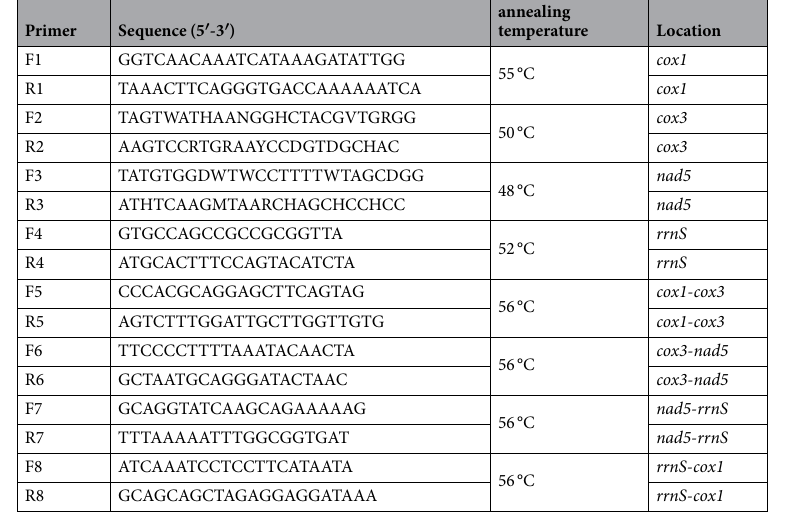
Table 1. Primers used in this study.